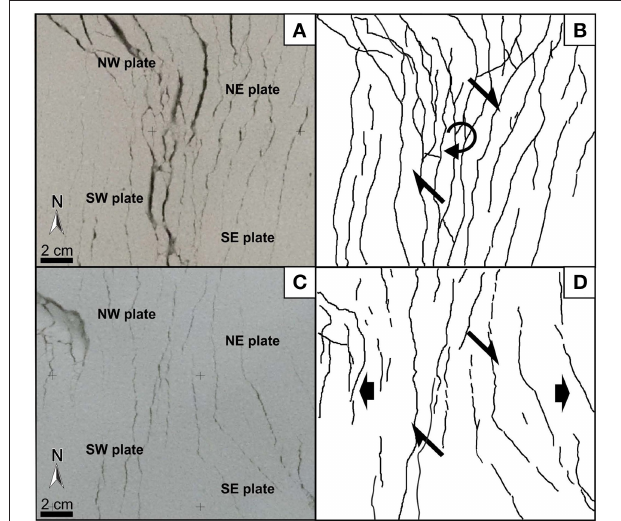
FIGURE 12 | Photos of the analog experiments and sketch of the resulting fracture field under different time relationships between the development of the rift zone (TFS) and the SE-ward prolongation of the transform fault (HFF). In (A) and (B; experiment 5) we observe the geometry of the tension fractures and faults obtained first by forming the rift zone and then by inducing the HFF right-lateral shear zone across the rift. (C) and (D) . represent, instead, the geometry when the rift zone develops contemporaneously to the right-lateral shear zone across it (i.e., the HFF prolongation). Note that case (C,D) . is in better agreement with the field